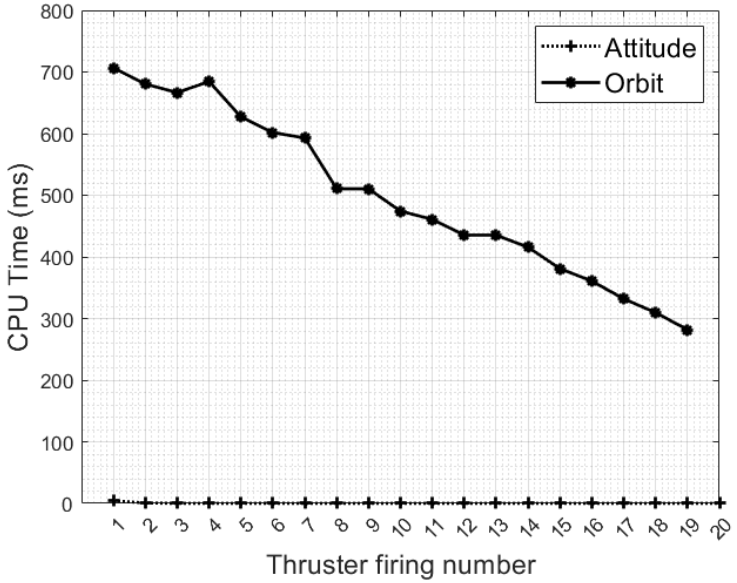
Figure 13. Computation time